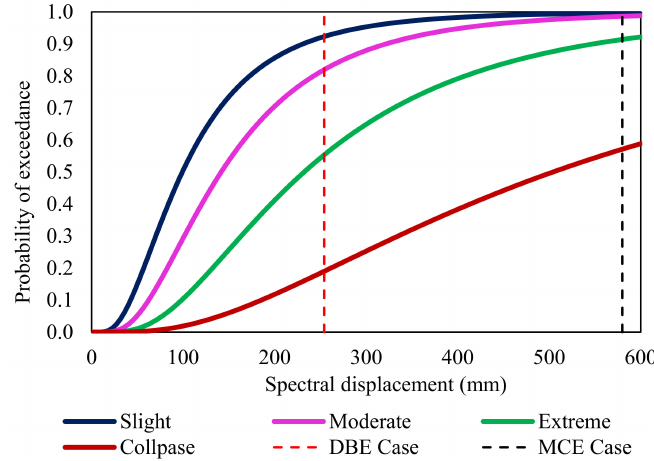
Figure 15. Fragility curve for unsymmetrical building Case IV (R = 6). From the fragility curves, the probability of the building exceeding each damage state was evaluated. The vertical line that intersects the fragility curves of various damage states was shown with regard to the spectral displacement at each design level. The likelihood percentage of exceeding for that particular damage condition is provided by the intersection